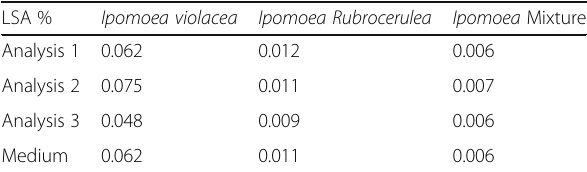
Table 1 Concentration of LSA in analyzed seeds LSA